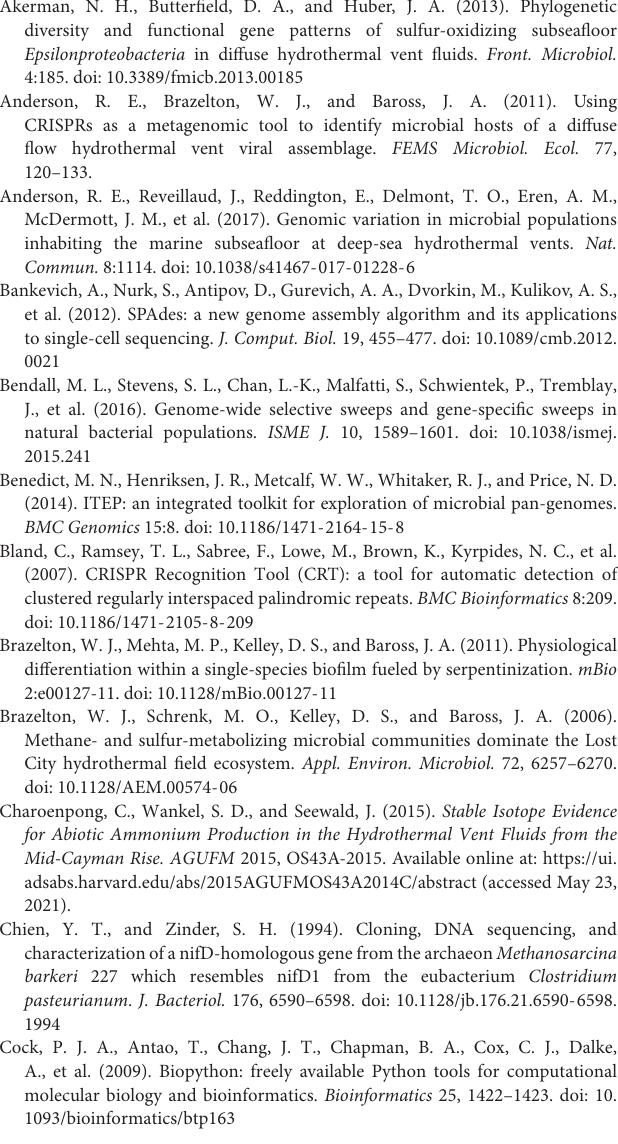
colored by SAG. Each point represents data from a different metagenome mapped to each SAG. Supplementary Table 1 | Data regarding quality filtering and assembly of metagenomic and metatranscriptomic reads. No MT, no metatranscriptome. NA, not available due to loss of USBL navigation by the ROV. Supplementary Table 2 | Percent reads mapping for all SAG-to-SAG mappings. SAG contigs used as reference are listed on the left, SAG reads mapped to the reference are listed along the top of the table. Numbers are listed as percent of merged reads mapped using bowtie2. Supplementary Table 3 | Selected gene counts for genes present and/or absent in each SAG from the Mid-Cayman